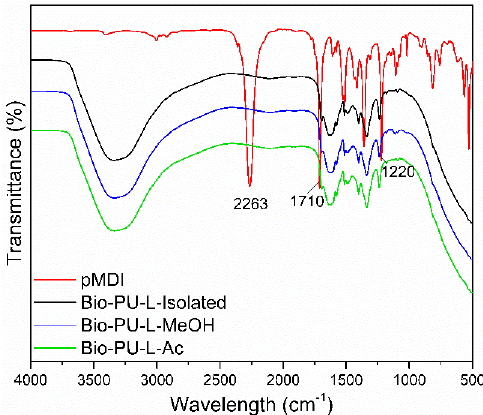
Figure 8. ATR ‐ FTIR spectra of Bio ‐ PU resin derived from fractionated lignin. Figure 8. ATR-FTIR spectra of Bio-PU resin derived from fractionated lignin.